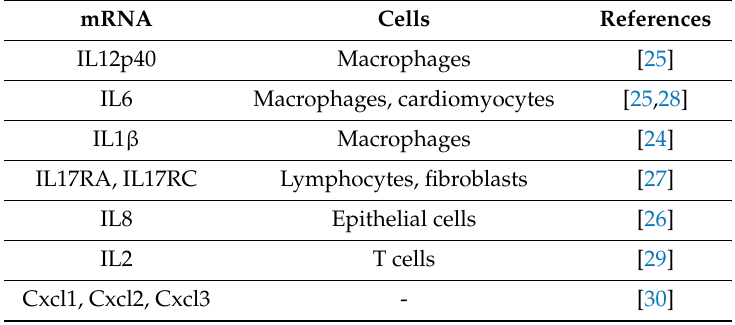
Table 1. mRNA of cytokines and chemokines degraded by MCPIP1 in various types of cells.